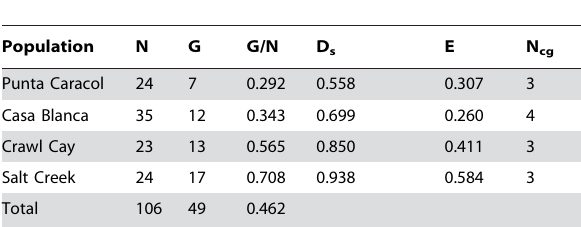
Table 1. Number of staghorn coral samples (N), unique genotypes or genets (G), and the ratio of genets per sample (G/N) per population along with clonal diversity (D s ), its evenness (E), and the number of genets with clones (N cg